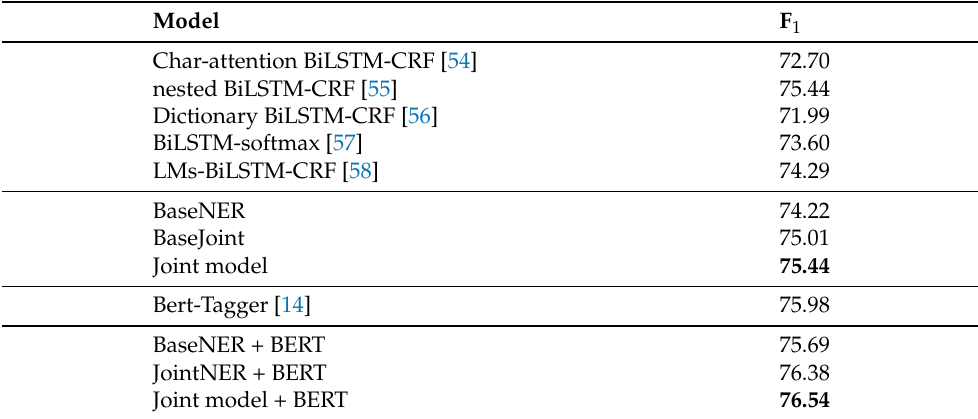
Table 7. F 1 -scores on the JNLPBA test